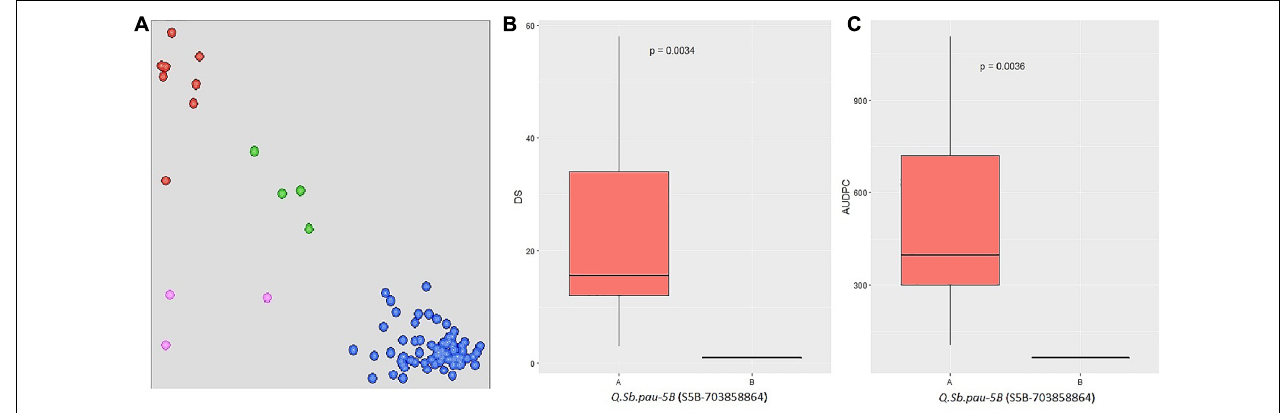
FIGURE 5 | (A) Validation of QTL using KASP assay on BC 2 F 1 population from DS13/HD 3086 with marker S5B_703858864. The central cluster (green) represents heterozygous individuals, whereas clusters near the axes are homozygous for resistant allele (HEX; red) and susceptible allele (FAM; blue). (B,C) Boxplots showing the effect of phenotypic variation between the two alleles of the QTLs for disease score and AUDPC of BC 2 F 1 population. Kruskal–Wallis test was used to determine the significant differences between the mean values of two